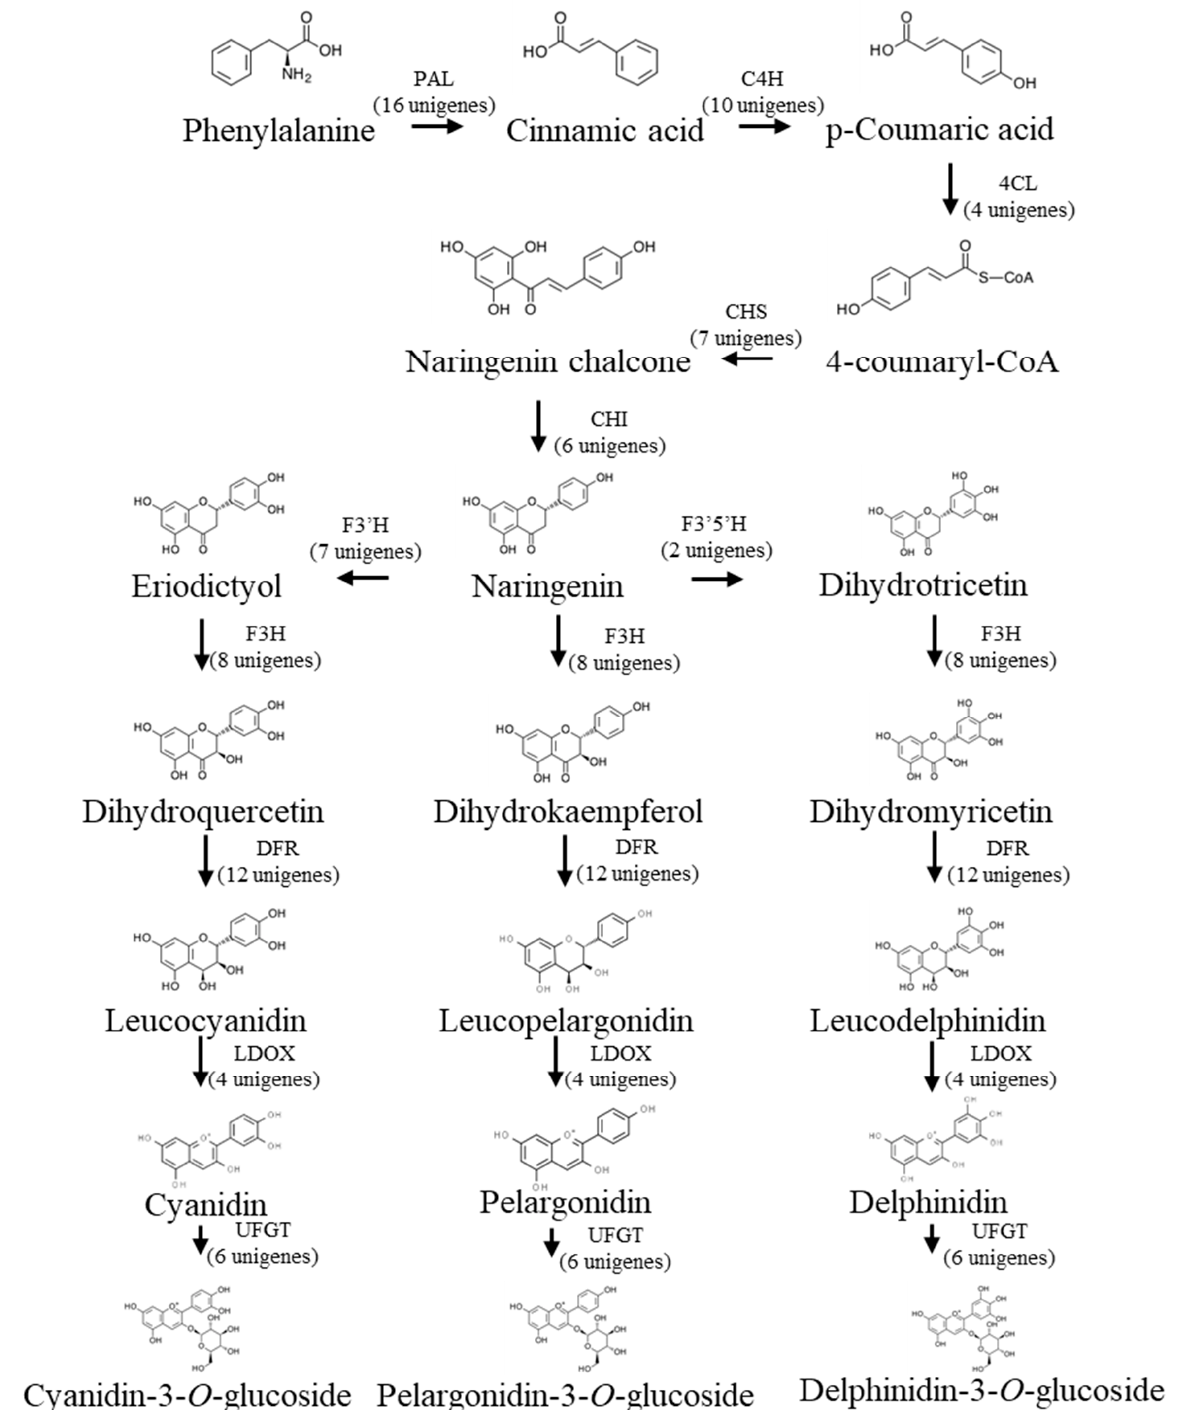
Figure 5. Unigenes from C. caudatus transcripts involved in the anthocyanin biosynthetic pathway. The number in brackets indicates the number of unigenes identified for the corresponding gene. The molecular structure of each compound was retrieved from the online database (KEGG and ChemSpider).